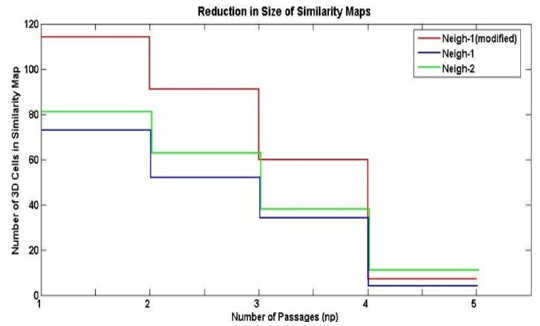
Figure 8: The progressive reduction of the size of similarity map S Map is